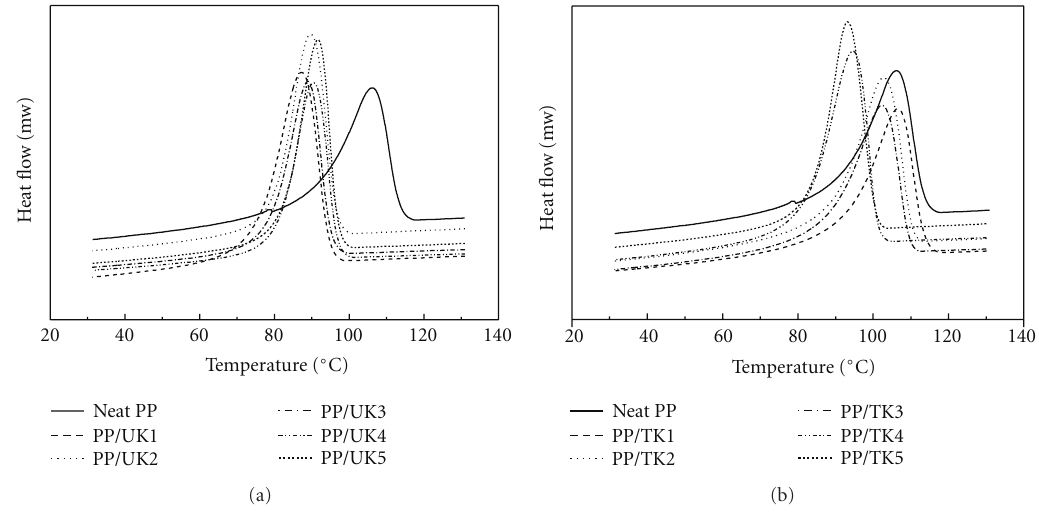
Figure 6: DSC thermograms of (a) PP/untreated kaolin and (b) PP/treated kaolin cooled from the melt at 20 ◦ C/min.